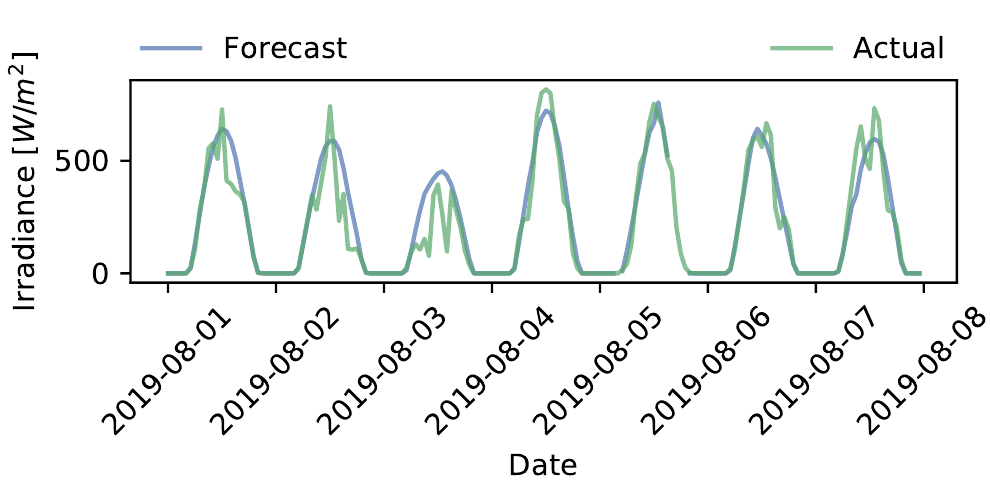
Figure 9. Comparison of forecasted and measured irradiance data during the first week of August 2019.